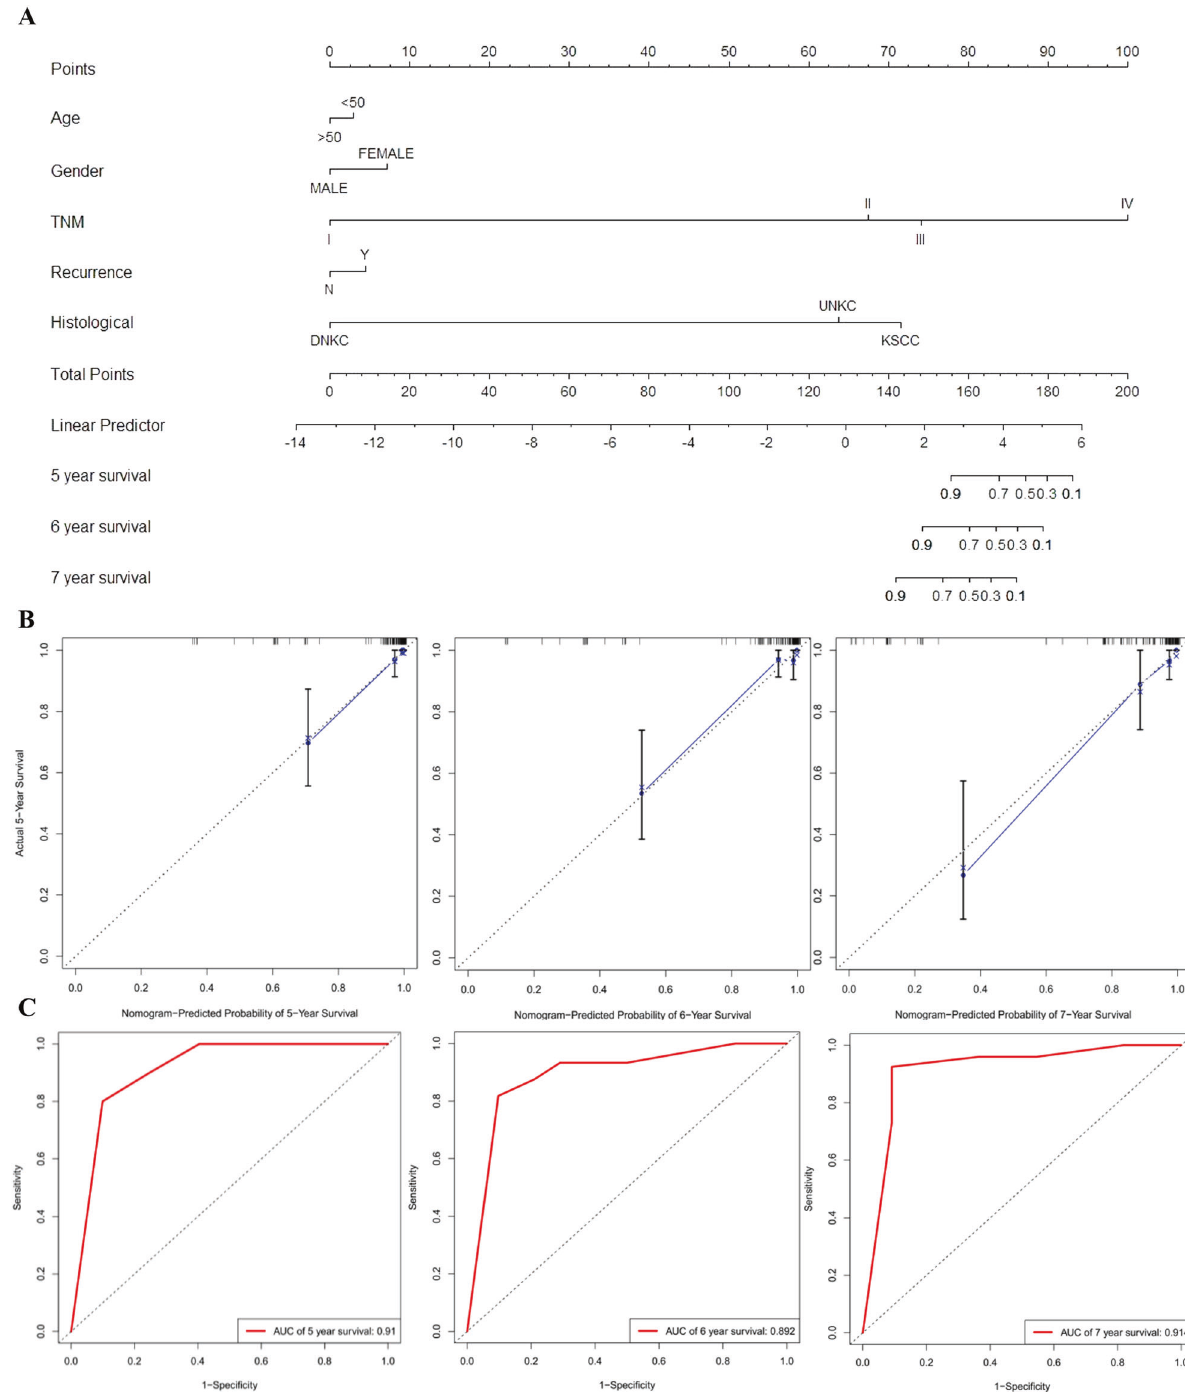
Fig. 3 A nomogram prediction model was constructed based on the expression of BART22 in NPC. A The nasopharyngeal carcinoma survival nomogram. (To use the nomogram, an individual patient ’ s value is located on each variable axis, and a line is drawn upward to determine the number of points received for each variable value. The sum of these numbers is located on the Total Points axis, and a line is drawn downward to the survival axes to determine the likelihood of 5-, 6- or 7-year survival). Risk of survival time can be determined by assigning points for each variable by drawing a line upward from the corresponding variable to the points line, summing the points, and identifying the prediction of survival time associated with the total points line. EBV-miR-BART-22, the level of tissue EBV-miR-BART-22 before treatment. B Calibration plots for predicting for NPC OS at 5-, 6-, and 7-year. The blue dotted line indicates the ideal nomogram; blue X indicates the bootstrap-corrected estimates; vertical bars indicate the 95% CIs. C ROC curves of the 5-, 6-, and 7-year nomograms of NPC patients. The red bars represent new nomogram-predicted OS, whereas the black bars represent TNM stage predicted OS.